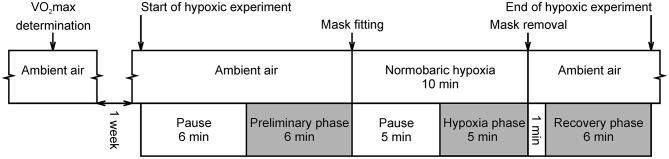
Course of experimental protocol. Gray colored phases were intended for oxygen saturation and ECG recording. Pauses were used to skip the transitory phase and to be able to assume stationarity of the data. This is a reprint of the figure entitled “Course of hypoxic experimental protocol” by Macoun et al. (9) and licensed under CC BY 4.0 (http://creativecommons.org/licenses/by/4.0/).